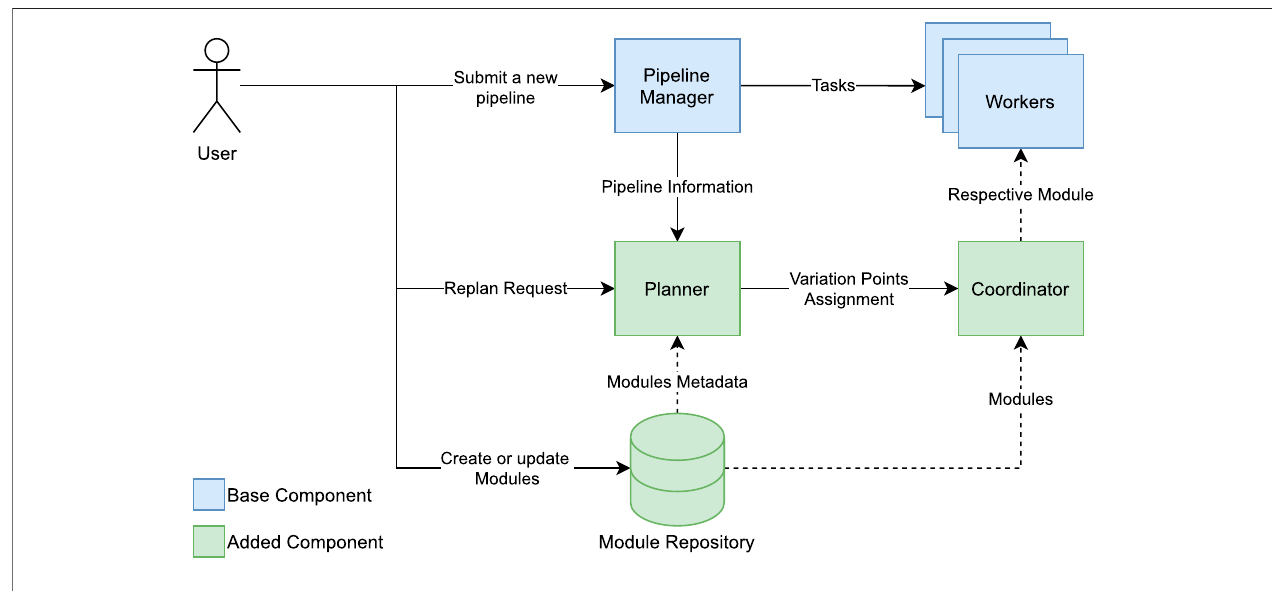
FIGURE 2 | Conceptual overview of the